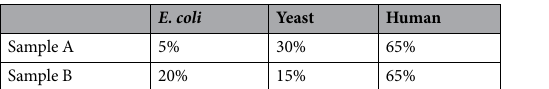
Table 2. Summary of the sample composition in the hybrid proteome benchmark